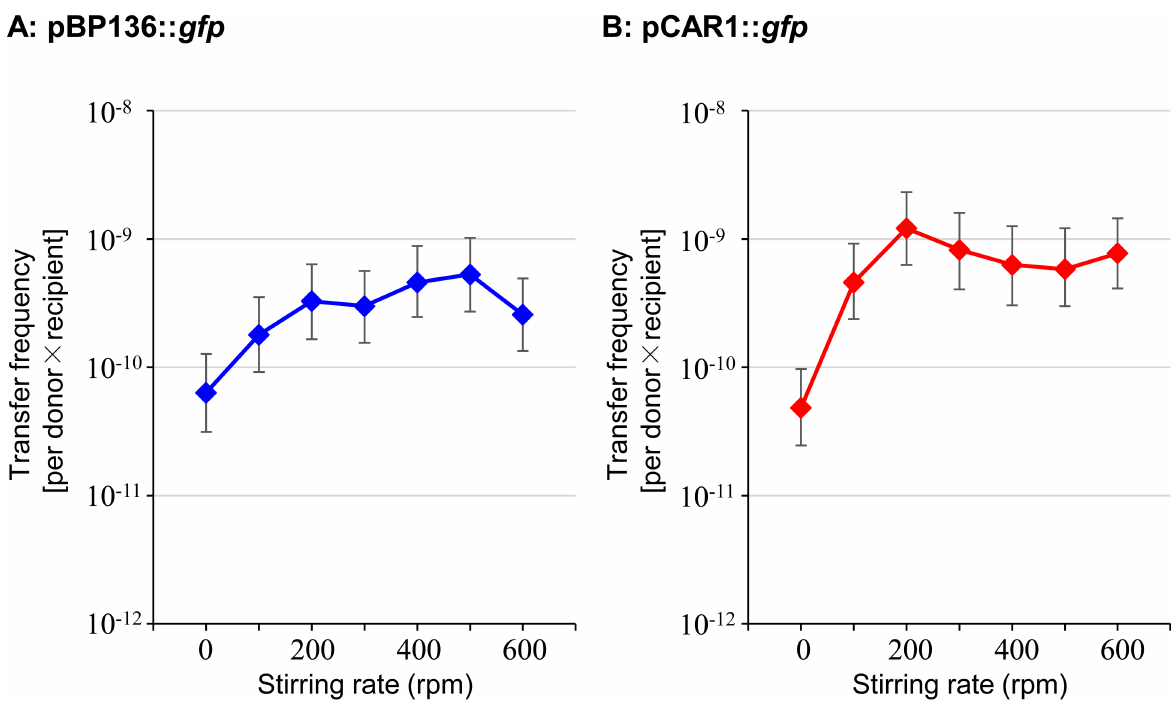
Fig 3. Comparisons of the transfer frequency of pBP136:: gfp (A) or pCAR1:: gfp (B) at cell density of 10 6 CFU/mL in higher stirring conditions (0 to 600 rpm). The raw data of this figure are in S3 Table.